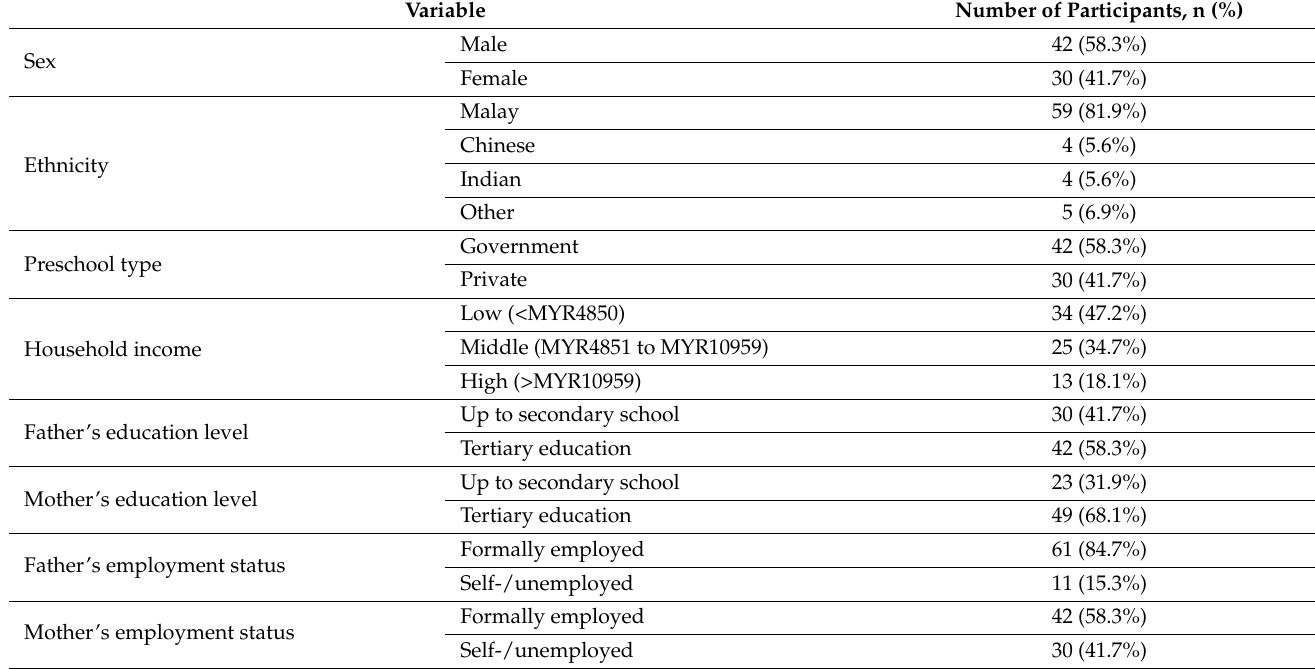
Table 1. Socioeconomic data of the study